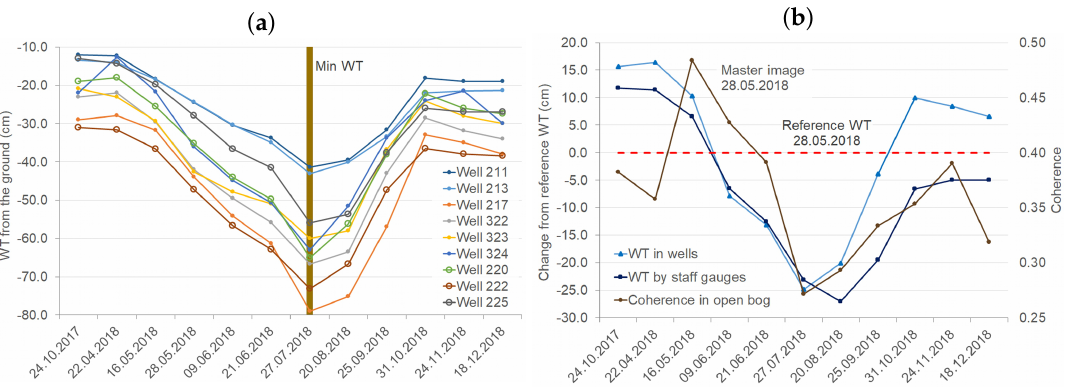
Figure 5. Water table (WT) depth from the ground in sampling wells in the open bog ( a ) and mean WT measured in wells and by staff gauges in bog pools related to mean coherence of the open bog ( b ). The master image for coherence estimation and reference for WT is 28 May 2018 ( b ). Min WT ( a ) stands for minimum observed WT in study period. Wells of Männikjärve bog are indicated with filled markers, Linnusaare bog with hollow markers ( a ). The lowest WT in peat coincides with the lowest mean coherence among the SAR image